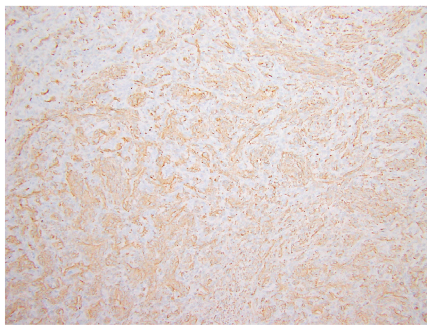
Figure 7: Staining for smooth muscle actin shows that myofi- broblastic areas (myoid component) are positive while the fibro- blastic areas (nonmyoid areas) are negative (10x